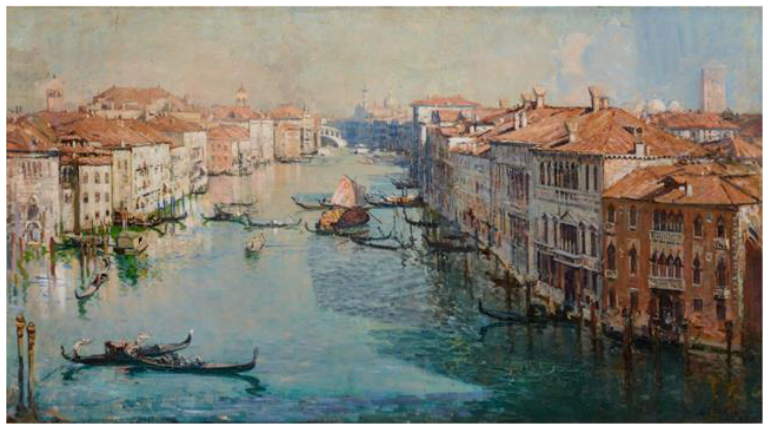
Figure 2. Arthur Streeton, The Grand Canal , 1908, oil on canvas, 92 × 168.5 cm.